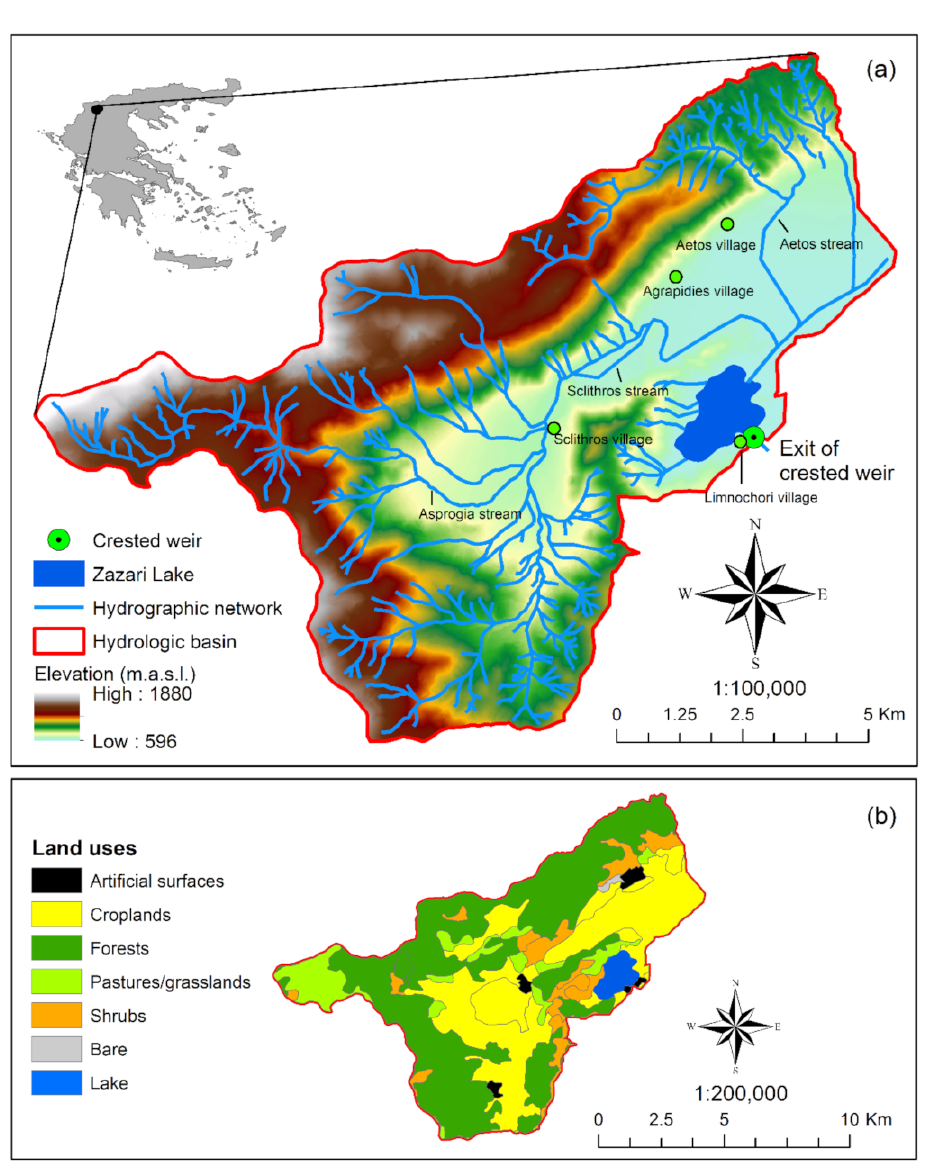
Figure 1. ( a ) Study site of Zazari basin and ( b ) land uses of the